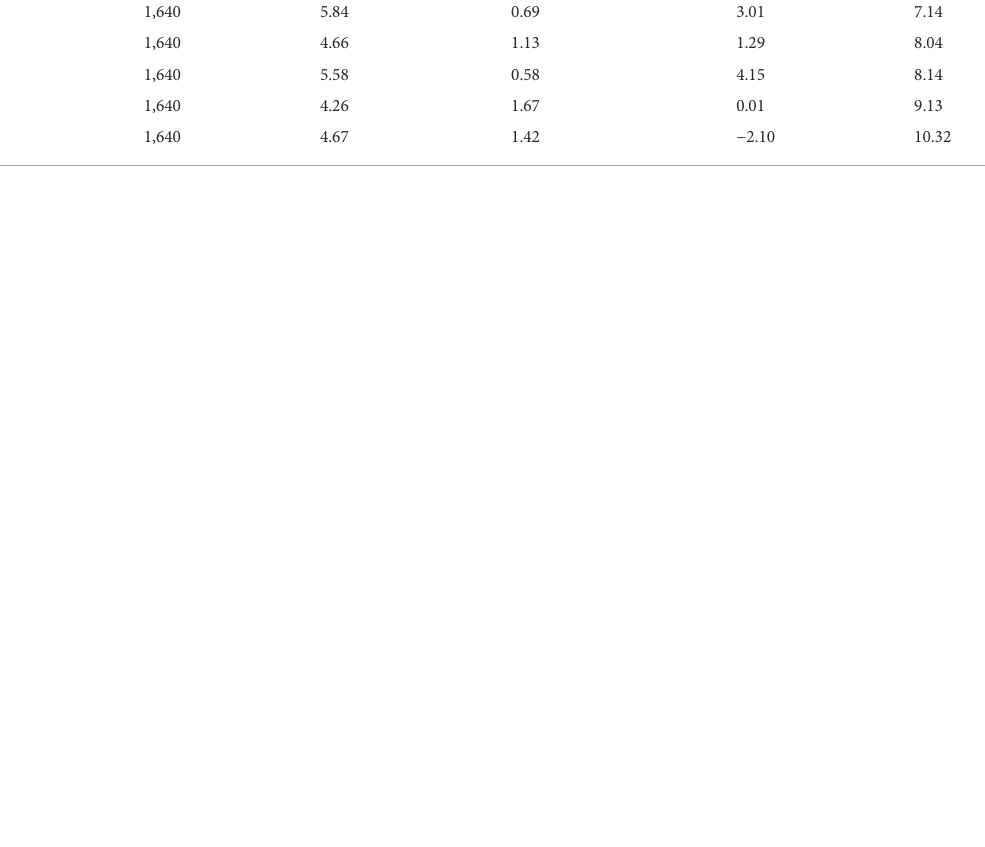
TABLE A2 Data descriptiveness and multi-collinearity test. Variable